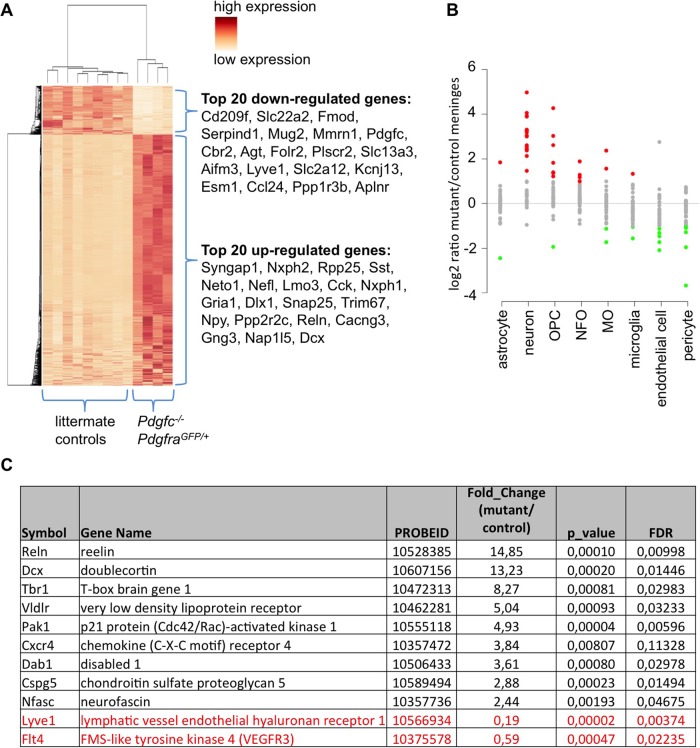
Differentially expressed genes in cerebral meninges. (A) Heat map showing the hierarchical clustering of differentially expressed genes in the meninges of Pdgfc−/−; PdgfraGFP/+ in comparison to littermate controls. Each row represents one gene and each column represents one animal. The expression levels are represented by color (dark color indicates high expression). The top 20 down- or upregulated genes are indicated to the right. (B) Gene expression changes in the top 40 cell-specific markers for eight different cell types, according to Zhang et al., (2014). Cell types are listed on the x-axis (OPC, oligodendrocyte precursor cell; NFO, newly formed oligodendrocyte; MO, myelinating oligodendrocyte). The y-axis represents the fold change (log2 scaled) between the mutants and the controls in meningeal samples. Each dot represents on gene (red, upregulated; green, downregulated; grey, no significant change). (C) Fold change, P-value and false discovery rate (FDR) of selected genes connected to neuron migration or lymphatic expression. Black genes are upregulated in mutant meninges; red genes are down regulated genes.